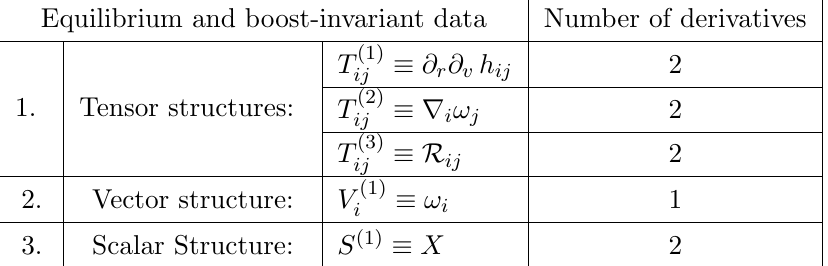
Table 5 . Relevant equilibrium and boost invariant data with maximum number of derivatives= 2, in four-derivative theories of gravity.